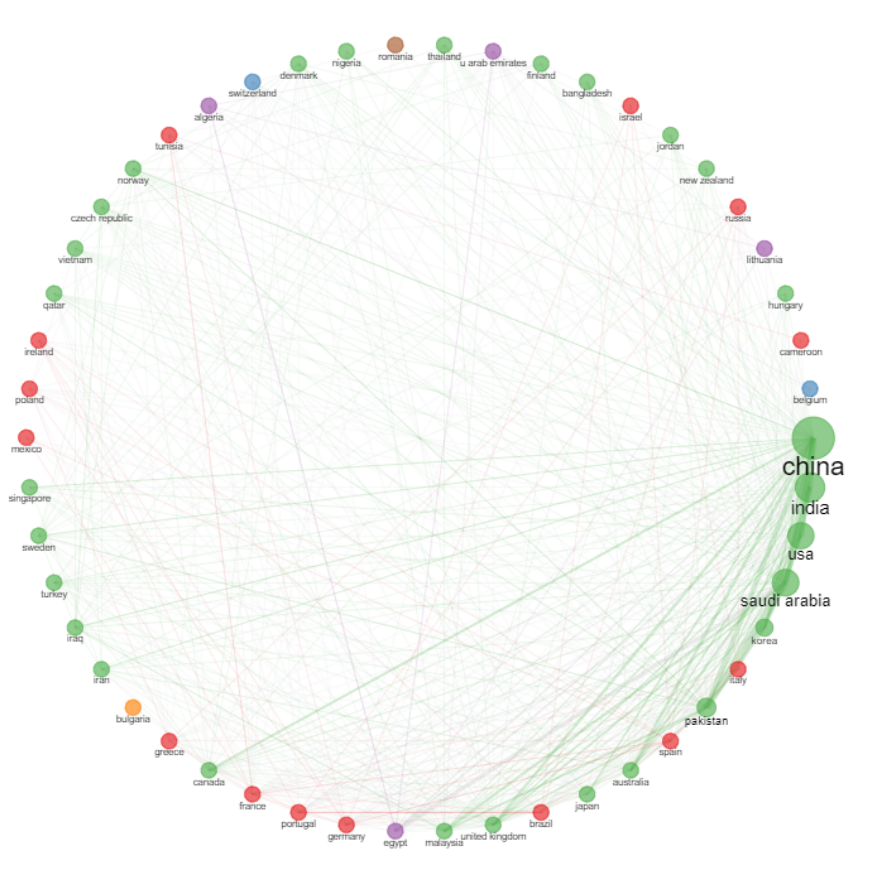
Figure 17. Collaboration network of different countries for IoMT research.